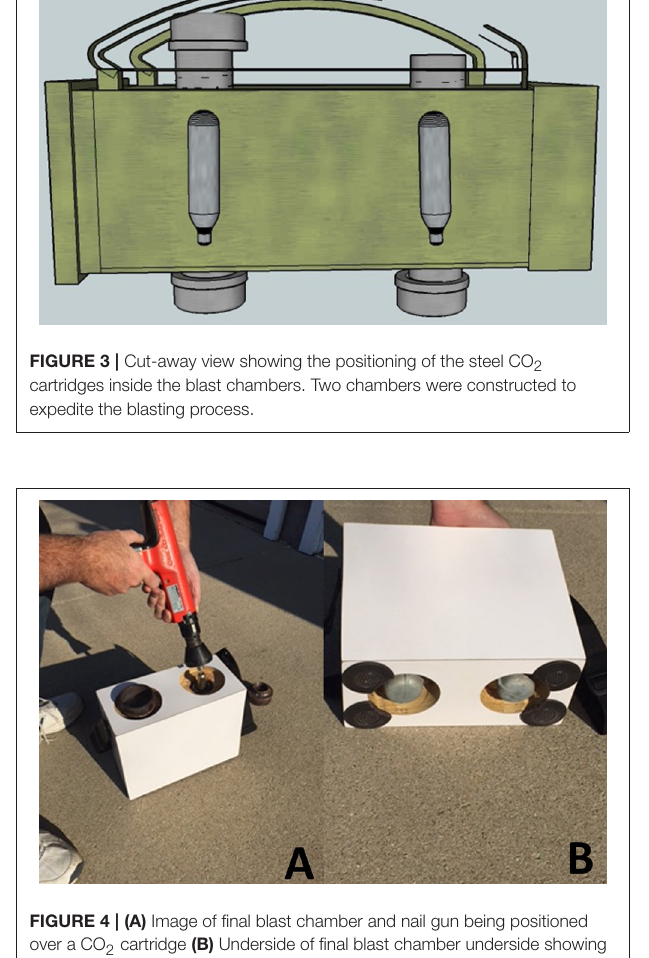
FIGURE 6 | Blood levels of LDH in “slosh,” “no-slosh,” and “control” groups, measured at 2, 4, 24, 48, and 72h post-blast. ‘*’ indicates statistically significant differences at the current time point relative to previous